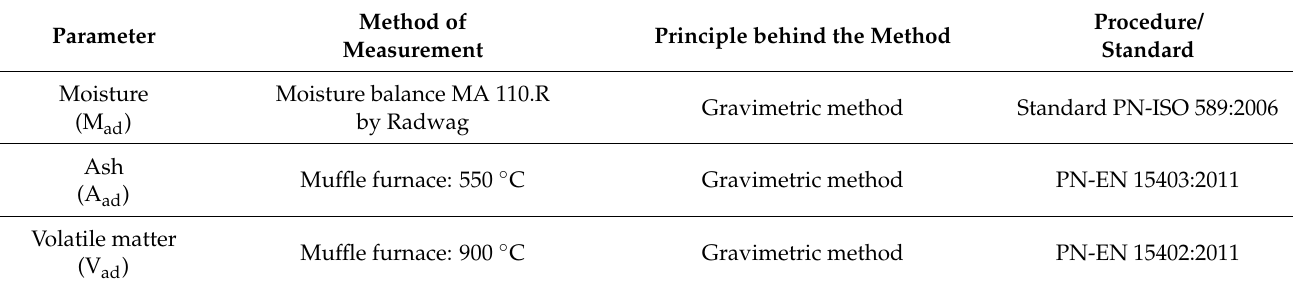
Table 2. Methods of examining the